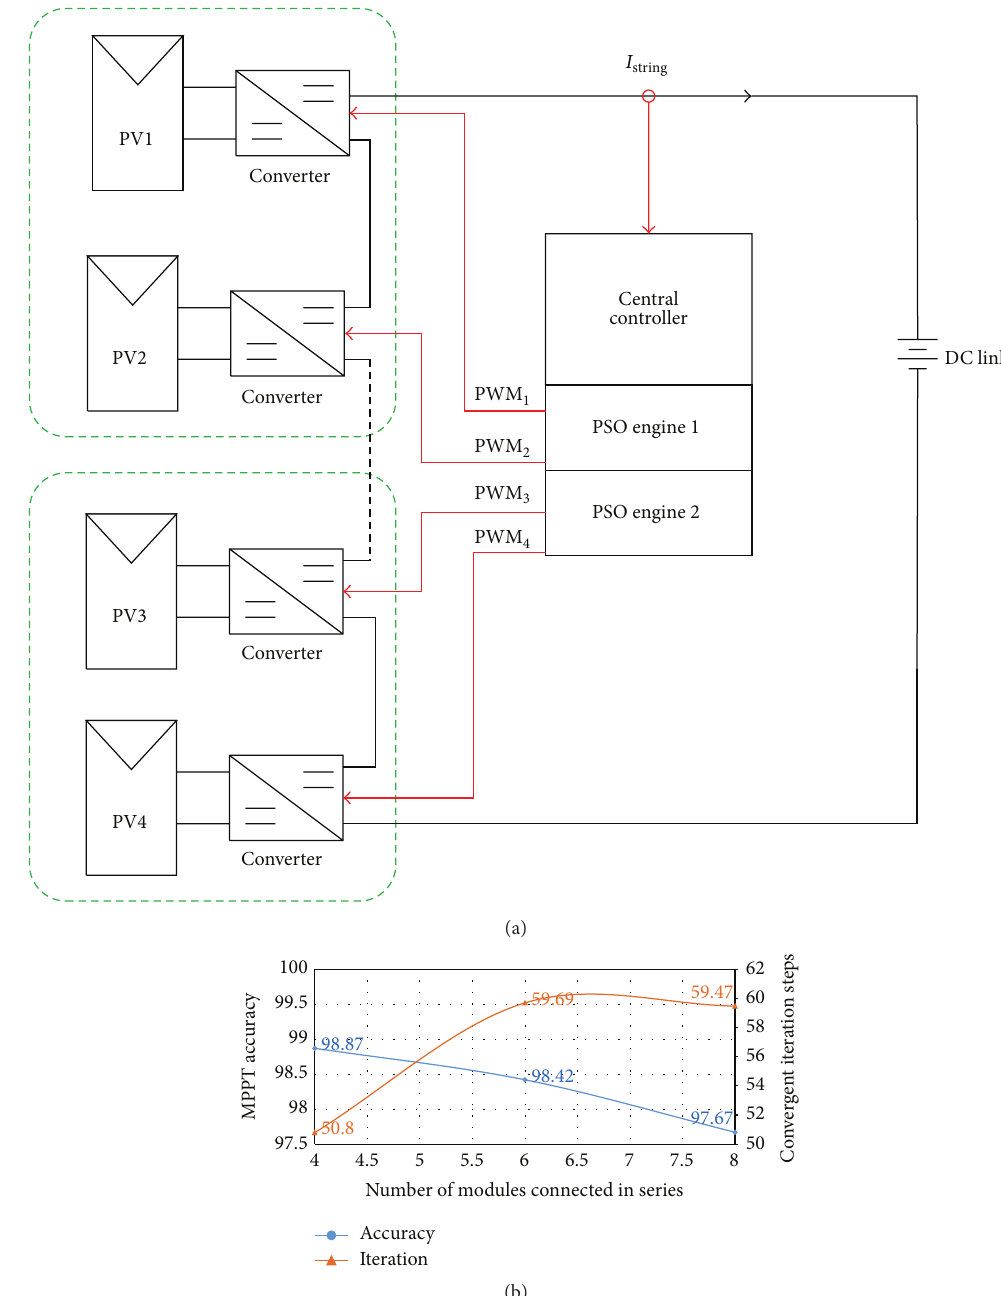
Figure 14: (a) Schematic diagram for two PSO engines operation of a distributed system, and (b) two-core tracking DMPPT performance.